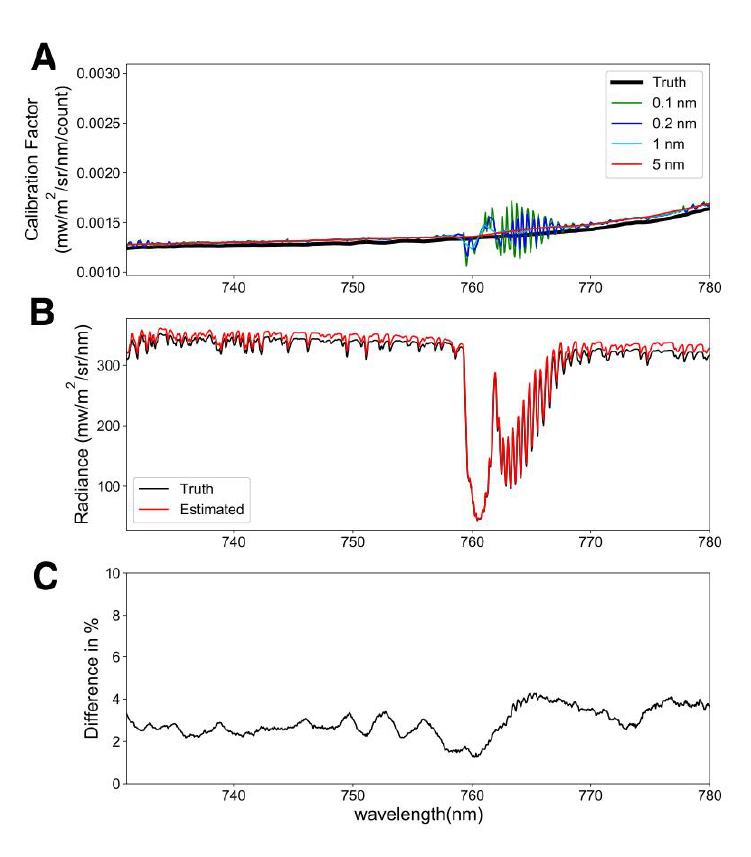
Figure 3. Field calibration of FluoSpec 2. ( A ) Calibration factors at four different spectral resolutions, compared with the true calibration factor obtained in the lab with an integrating sphere. ( B ) Comparison between the radiance spectrum estimated with lab calibration and the spectrum estimated with cross calibration. ( C ) Relative difference between the truth and the estimated spectrum.